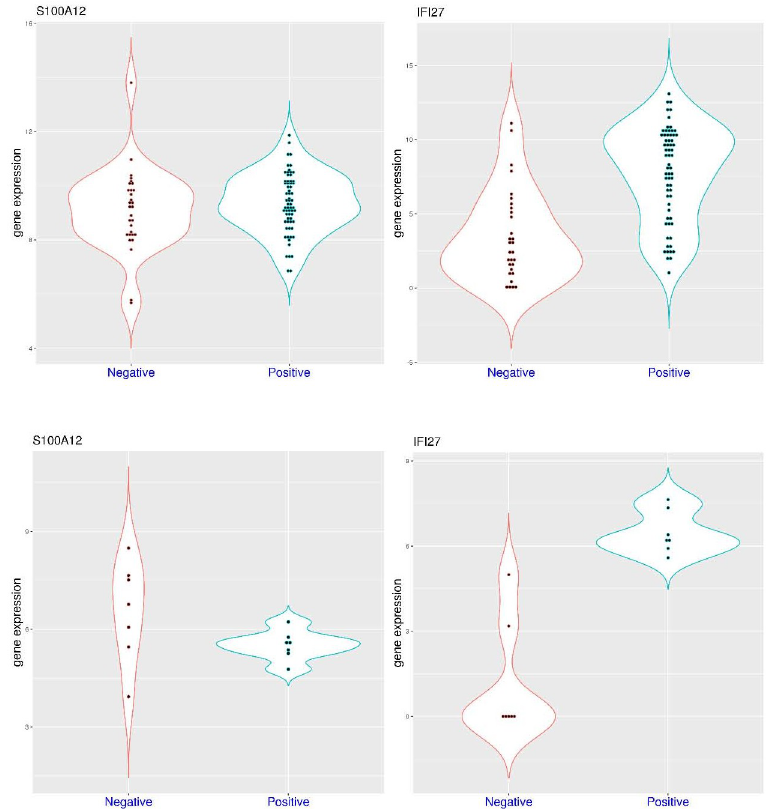
Fig 2. Expression level of S100A12 and IFI27 in hospitalized patients with and without COVID-19 (whole blood). A) upper panel (dataset GSE167000), comparison of S100A12 and IFI27 expression in non-critical patients with and without COVID-19. B) lower panel (dataset GSE154998), comparison of S100A12 and IFI27 expression in intensive care unit (ICU) patients with and without